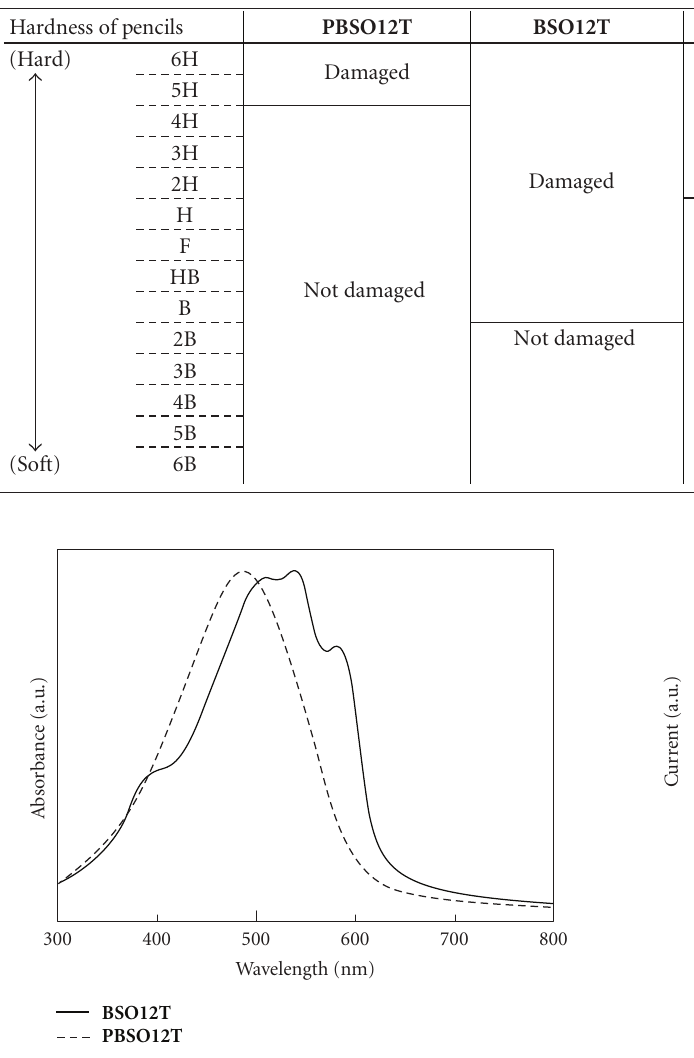
Figure 9: Cyclic voltammograms of BSO12T and PBSO12T films in TEAP (0.1M)/acetonitrile at a scan rate of 50mVs − 1